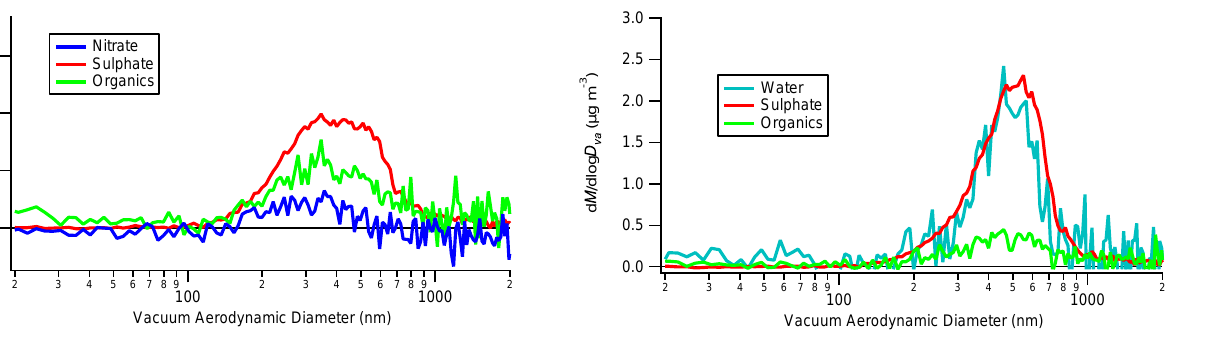
Fig. 8. Mass size distributions for an episode with exceptionally high sulfate concentrations (1 September 2006, 00:00UTC to 2 September 2006, 19:00UTC). During this episode particle-bound water was detected with a size distribution similar to the sulfate size